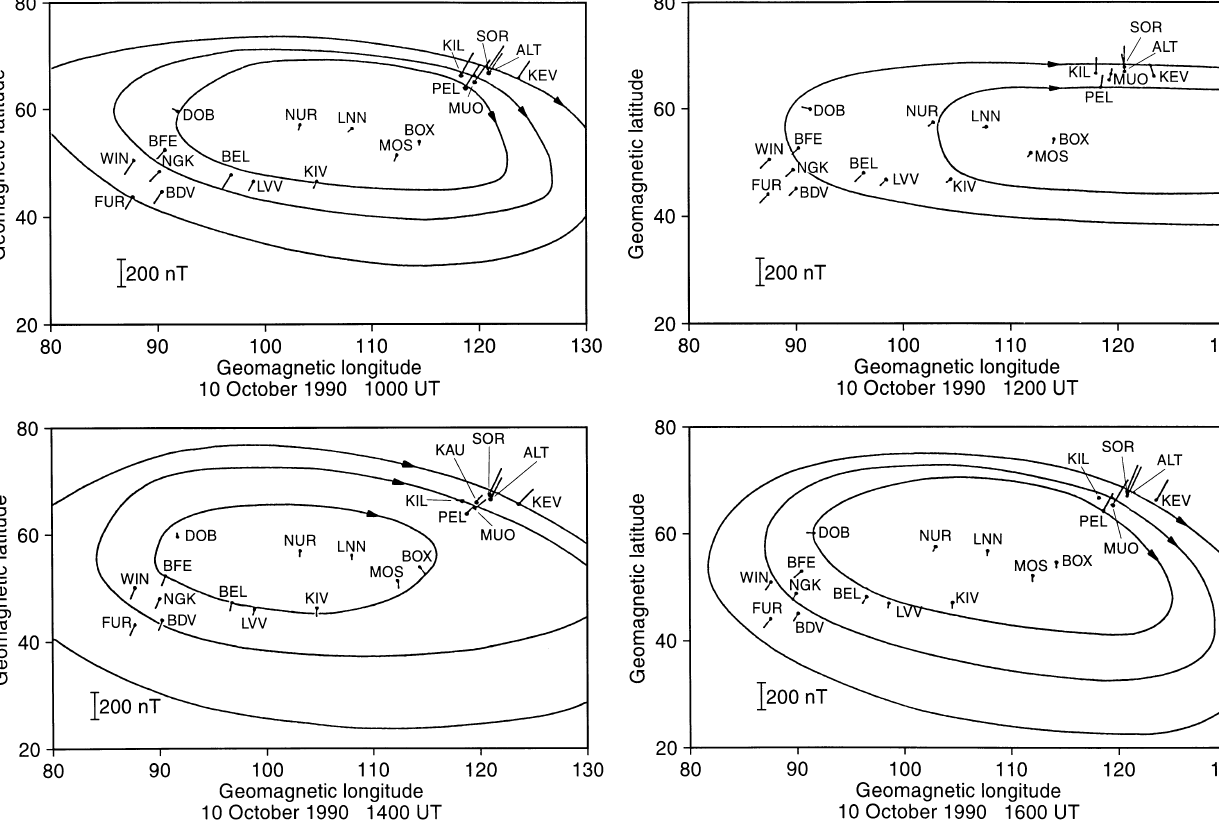
Fig. 10. Horizontal magnetic disturbance vectors and the equivalent ionospheric current system, respectively, for di(cid:128)erent time moments on 10 October 1990